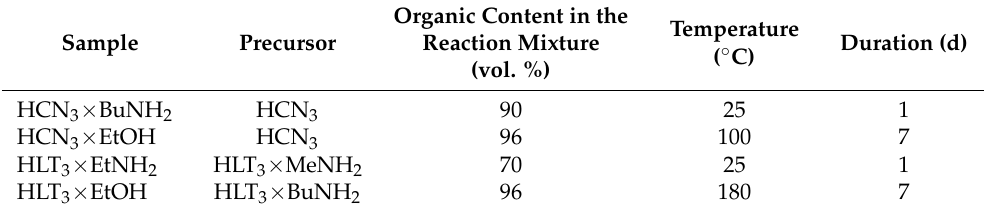
Table 1. Conditions for the synthesis of the inorganic − organic derivatives. Organic Content in the Sample Precursor Reaction